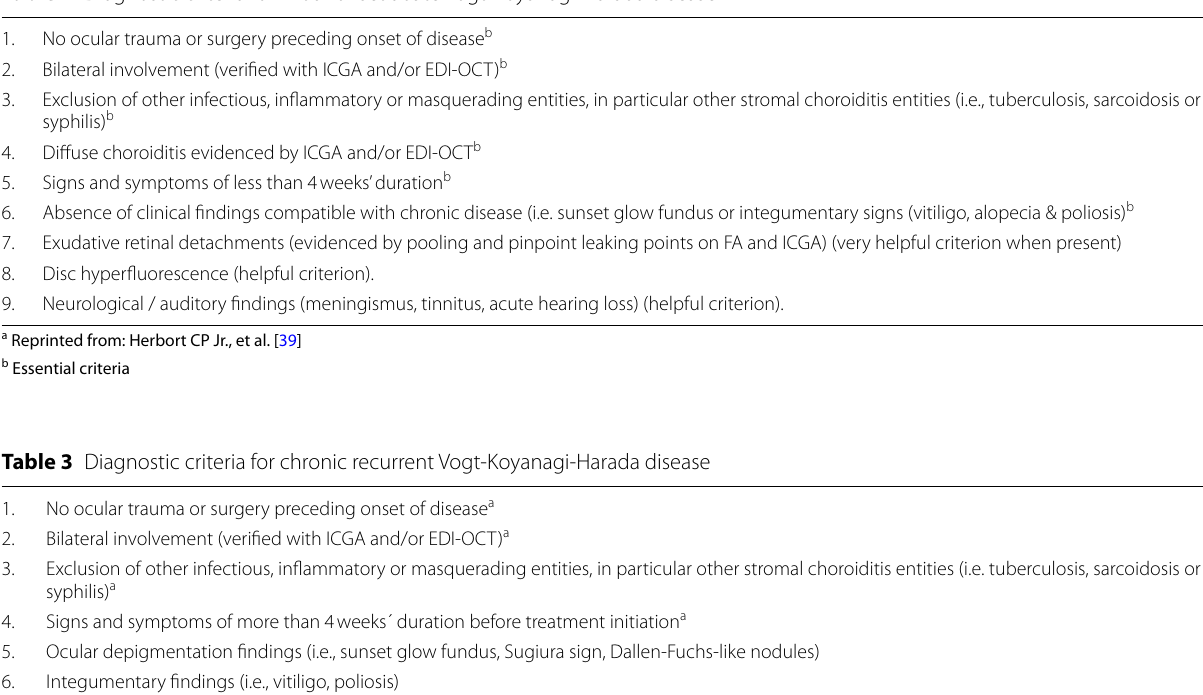
Table 2 Diagnostic criteria for initial‑onset acute Vogt‑Koyanagi‑Harada disease a